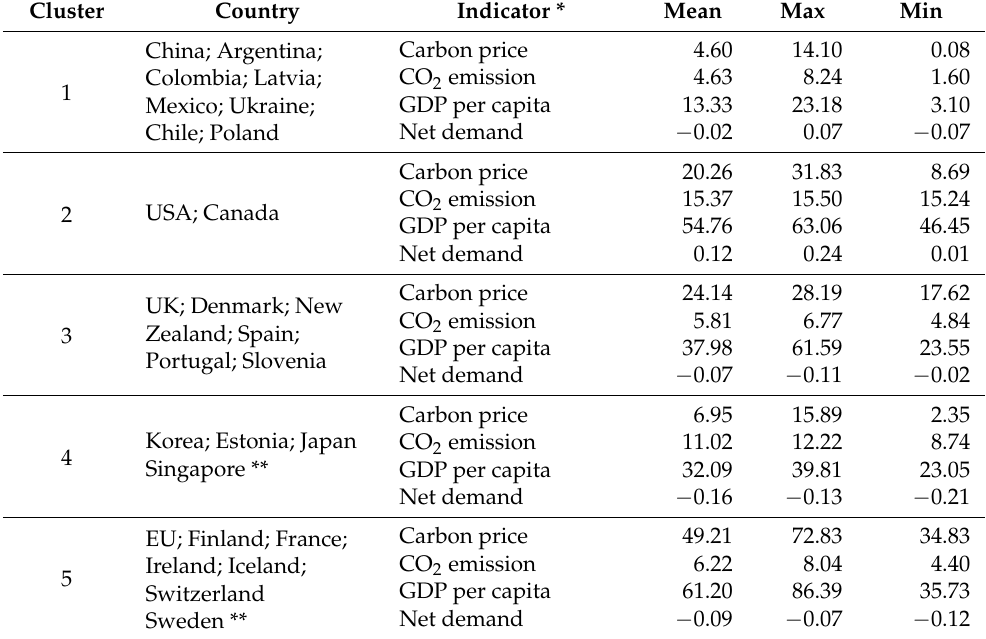
Table 4. Clustering according to the economic, environmental and fossil fuel demand factors. Cluster Country Indicator * Mean Max